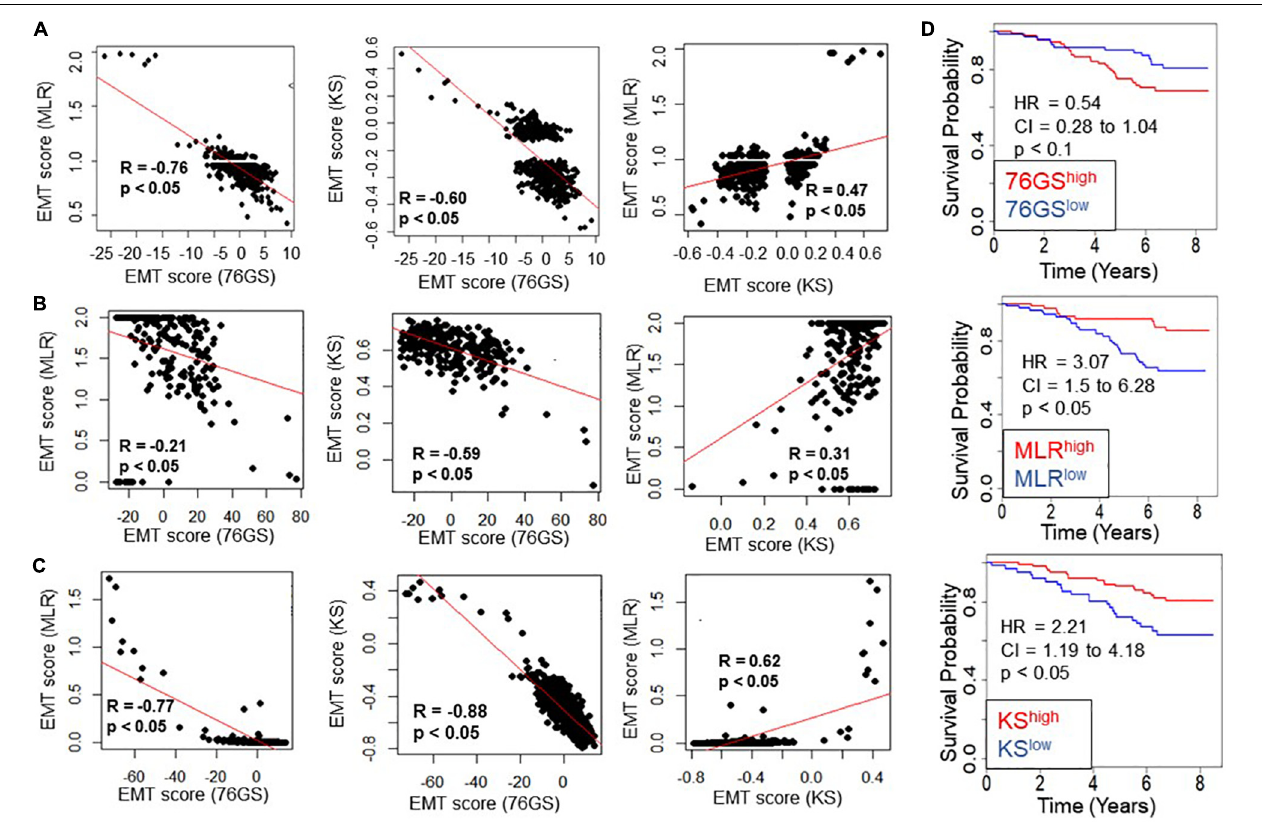
FIGURE 3 | Concordance across all three EMT scoring methods in quantification of EMT and survival prediction of tumor patients. Each pairwise relation is estimated by linear regression (red), Pearson’s correlation coefficient ( R ), and p -value ( p ), reported in each plot. (A) TCGA ovarian cancer dataset, (B) TCGA sarcoma dataset, (C) TCGA breast cancer dataset. (D) Correlation between EMT score (high vs. low) and overall survival (OS) in breast cancer patients. Kaplan–Meier survival analysis is performed to estimate differences in survival of 76GS high , MLR high , KS high and 76GS low , MLR low , KS low groups, respectively, in GSE1456. p -values ( p ) reported are based on the log rank test. HR (hazard ratio) and confidence interval (95% CI) reported are estimated using cox